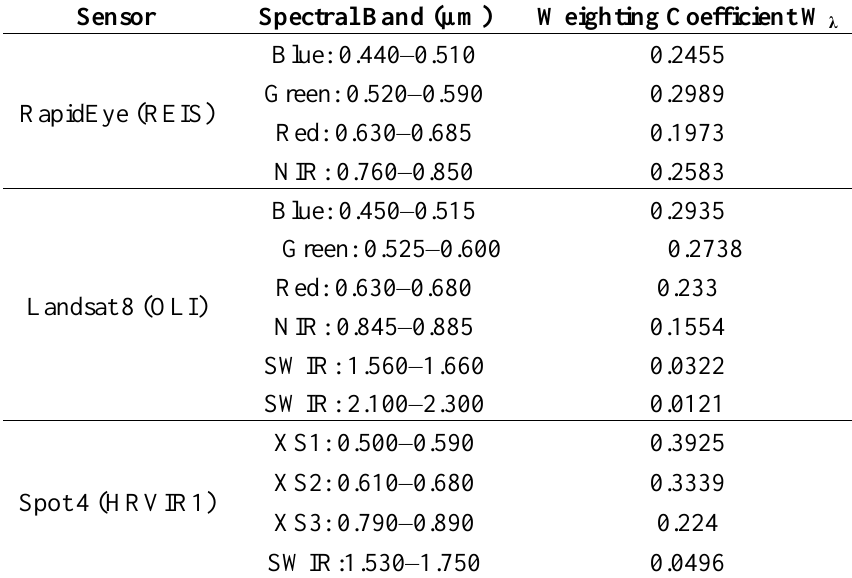
Table 4. Weighting coefficients for the calculation of albedo α by using Equation (13) for different